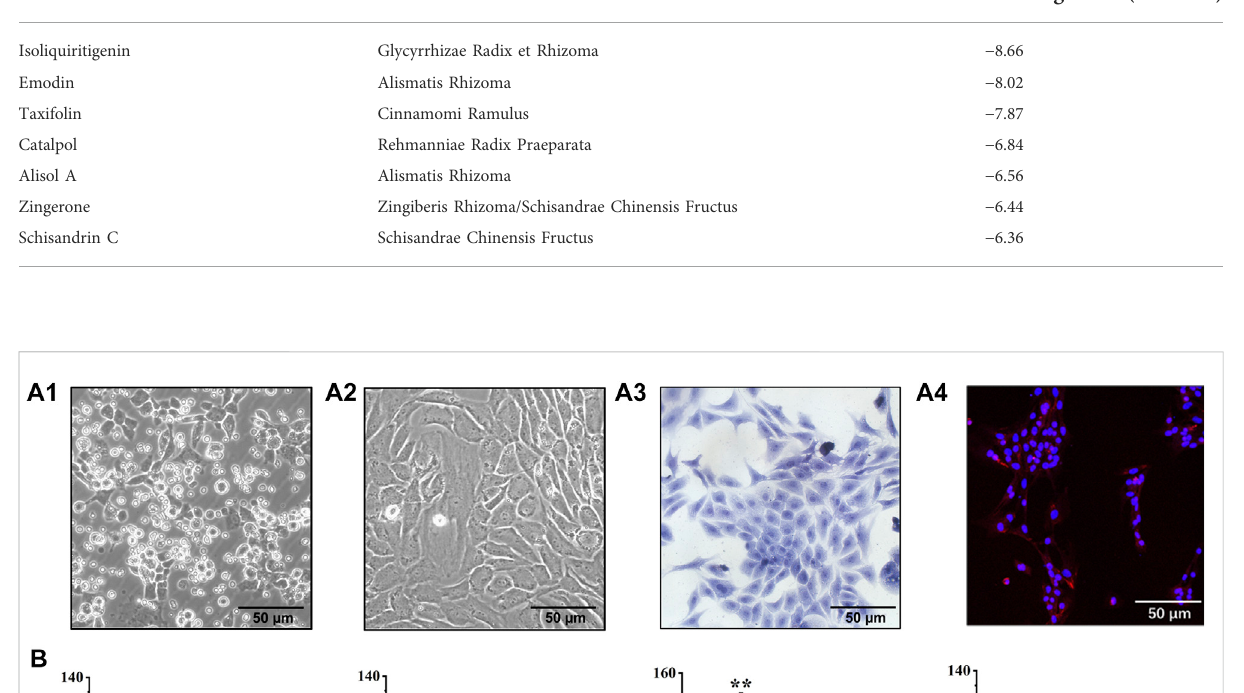
with IL-1 β . As shown in Figure 4A, most of the seven constituents reversed the decline of PPAR γ in chondrocytes IL-1 β -treated.